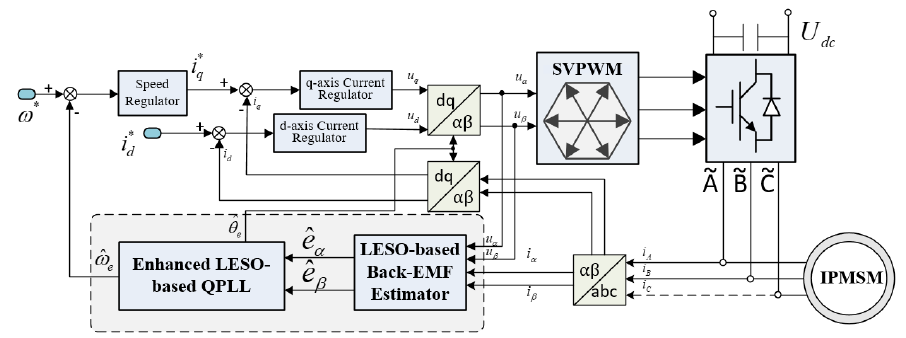
Figure 11. Block diagram of the IPMSM sensorless control system.